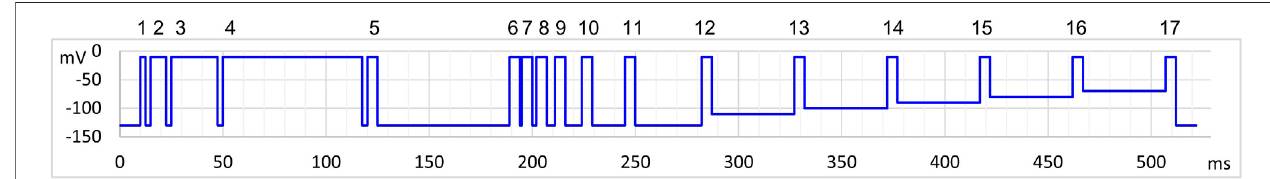
FIGURE 1 | Schematic picture of the voltage protocol. Pulses are numbered for